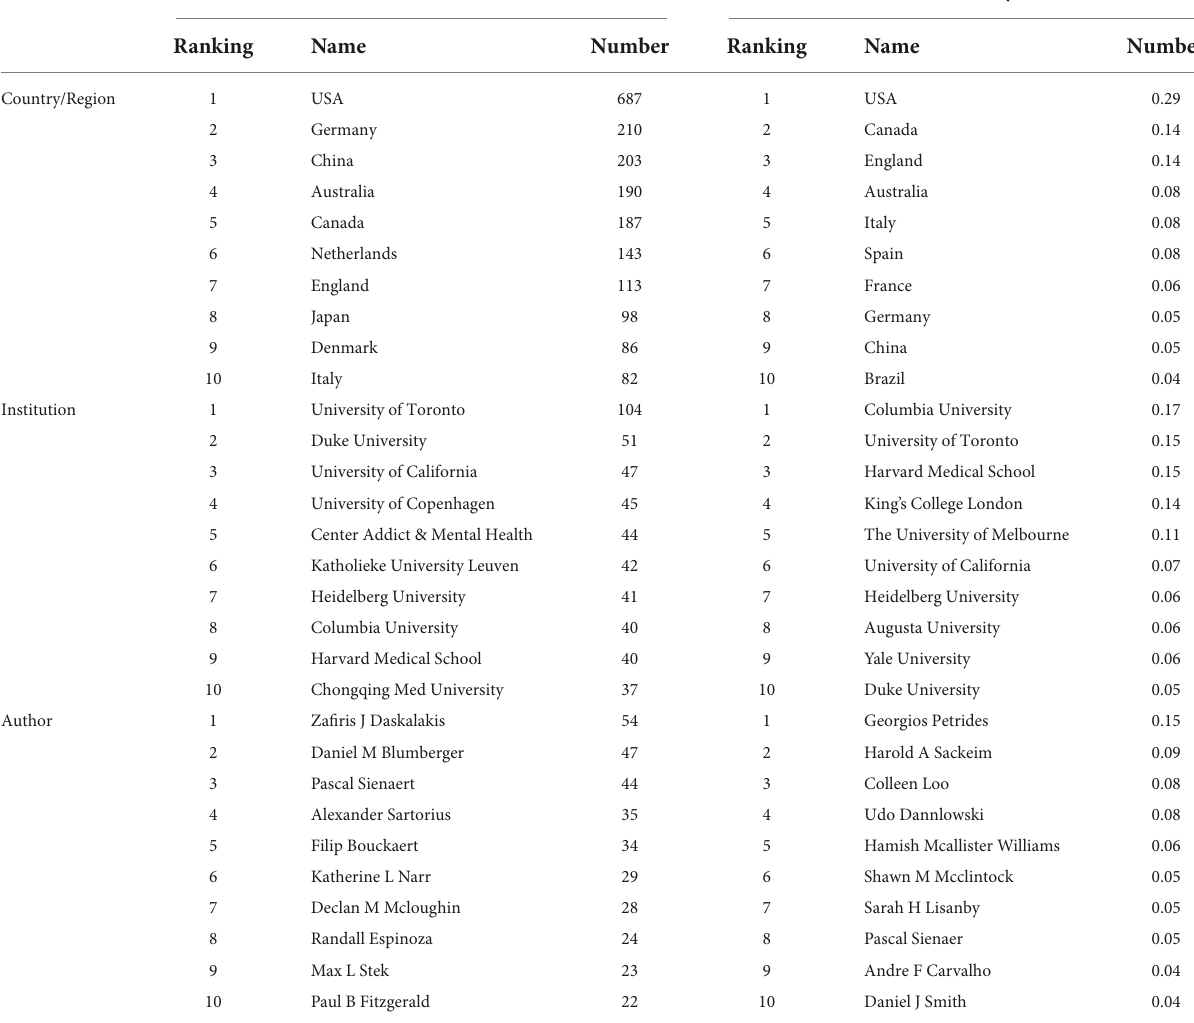
TABLE 1 Top 10 countries/regions, institutions, and authors according to publications and centrality.